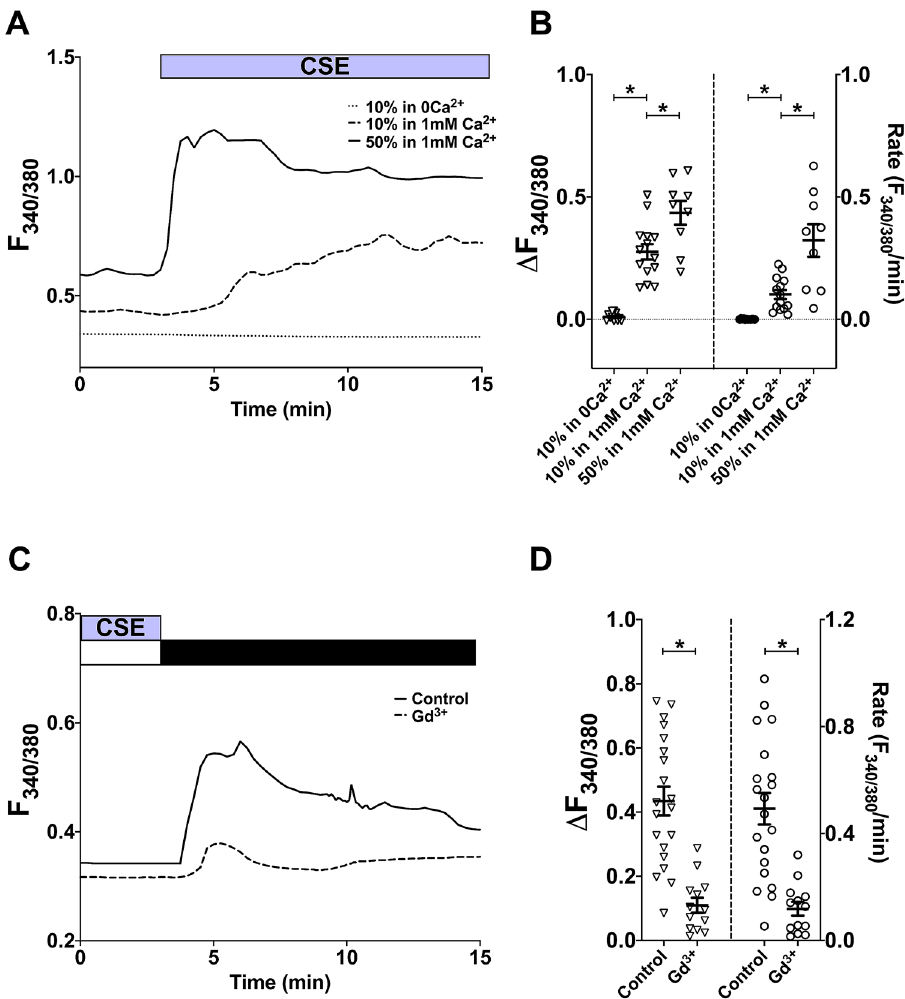
Figure 2. Diluted CSE also activates Ca 2+ influx in hASMC. (A,C) Representative Ca 2+ imaging traces from separate experiments tracking changes in [Ca 2+ ] i following perfusion with diluted CSE with or without extracellular Ca 2+ (A) , or following Ca 2+ addback (1 mM Ca 2+ ; black bar) after 5-min perfusion with 10% CSE in a nominally Ca 2+ -free solution (white bar), with or without 10-min pre-treatment with 100 µM Gd 3+ , which was also present throughout the experiment (C) . (B,D) Summary of amplitude and rate of [Ca 2+ ] i changes corresponding to experiments in (A,C) , respectively, presented as mean ± SEM. One-way ANOVA with Holm- Sidak’s multiple comparisons test was ran amongst the 3 groups ( B ; 3 independent donors; n = 9–14); unpaired t-test was performed between the control group and the Gd 3+ -treated group ( D ; 3 independent donors; n = 13–20). *p < 0.05. Control in (C,D) refers to CSE-activated Ca 2+ addback without Gd 3+